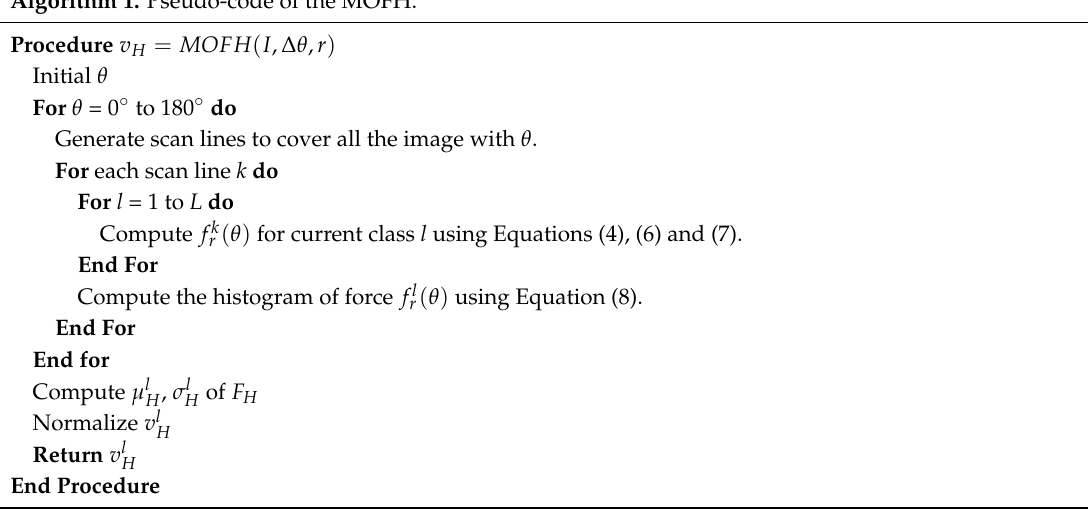
Algorithm 1. Pseudo-code of the